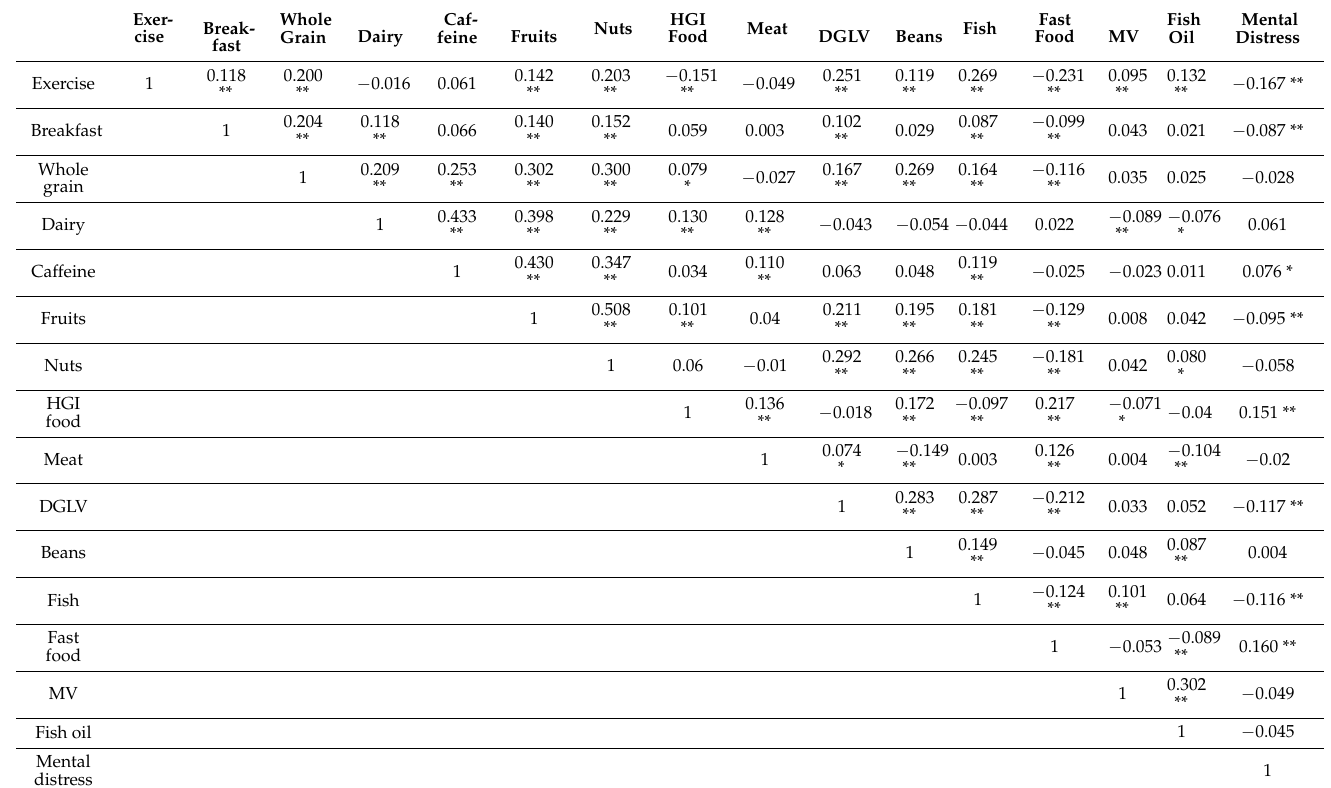
Table 5. Spearman’s rank–order correlation results for mature women.